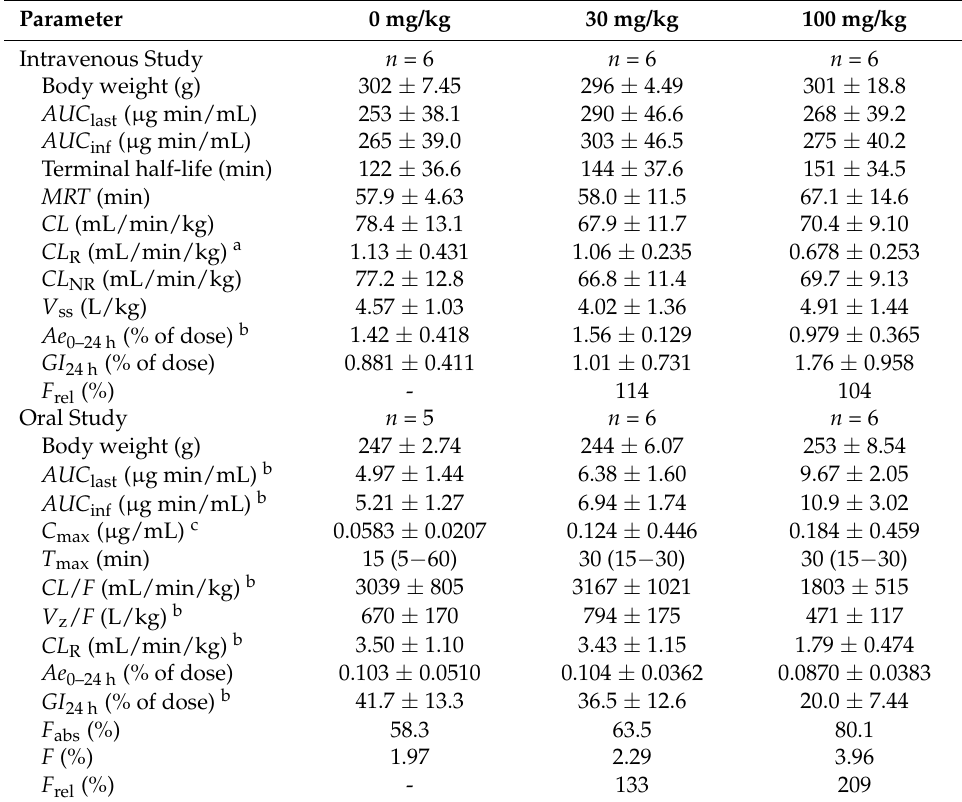
Table 2. Pharmacokinetic parameters of docetaxel after intravenous and oral administration of docetaxel (20 mg/kg) with 0, 30, or 100 mg/kg of LC478 in